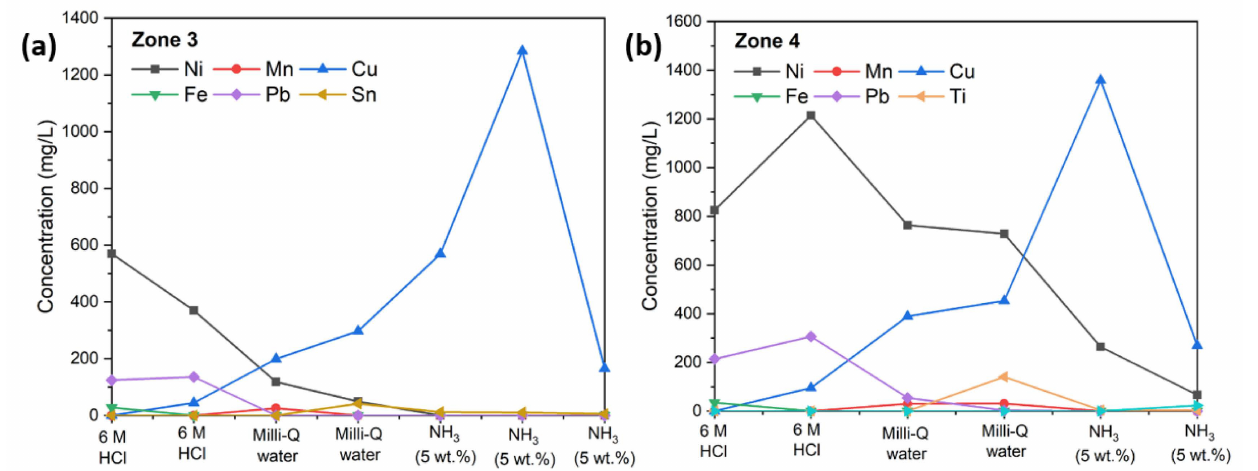
Figure 1. ( a ) Concentrations of metals after the multistep back-extraction process for zone 3. ( b ) Concentrations of metals after the multistep back-extraction process for zone